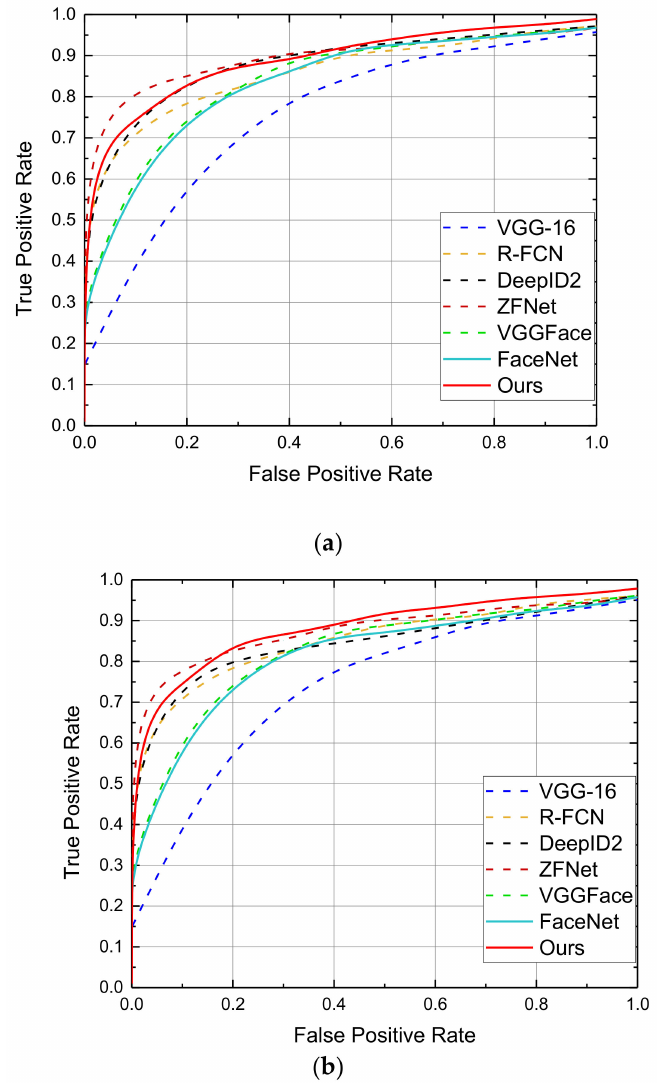
Figure 20. ROC curve for different models on validation sets and test sets after region detection. ( a ) ROC curve for different models on test sets; ( b ) ROC curve for different models on validation